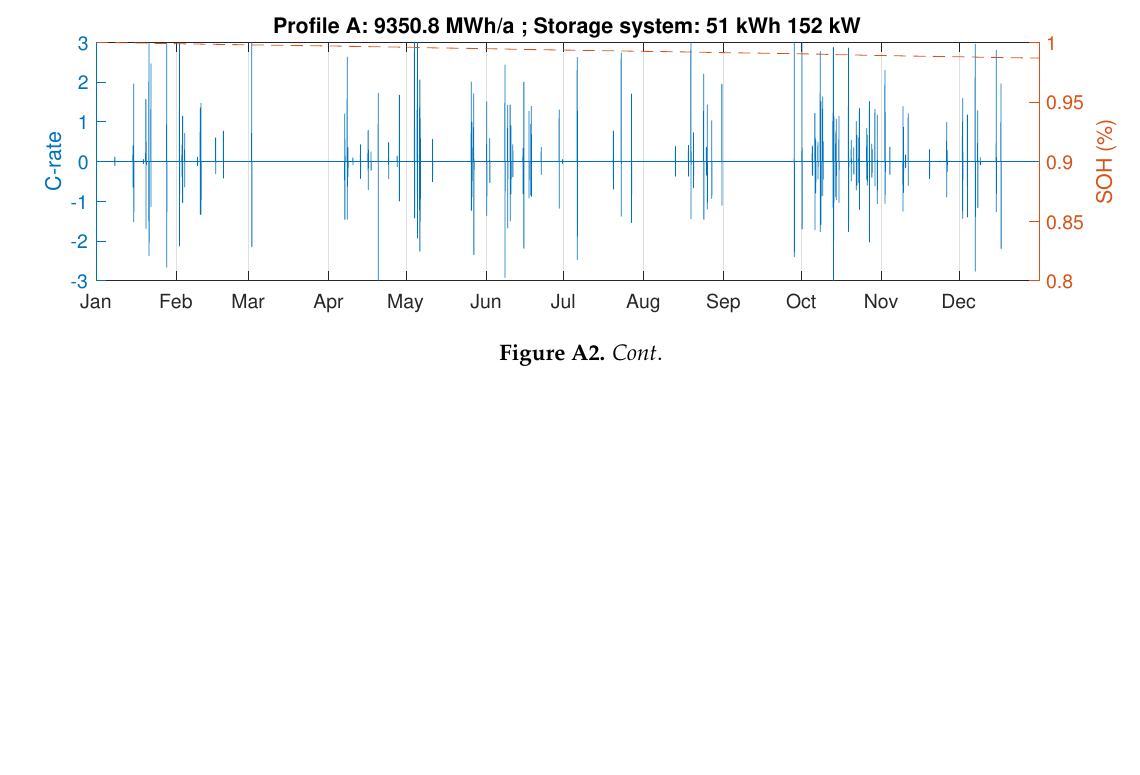
Figure A1. Battery power profile with yearly billing scheme and resulting state of health decline.